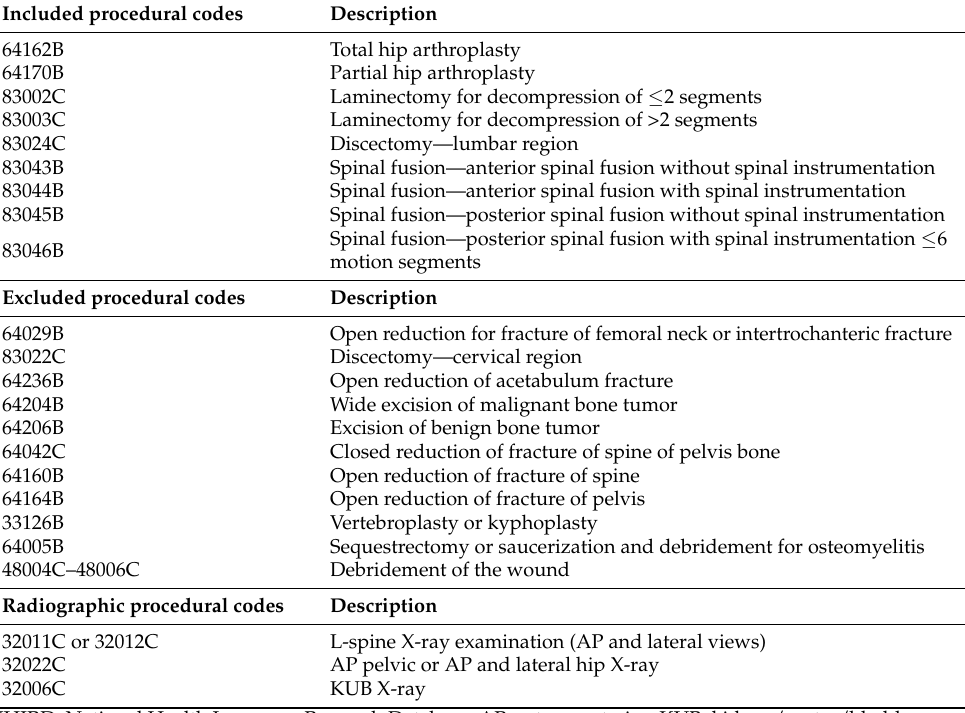
Table A1. Summary of spine, hip arthroplasty, and radiology procedure codes used to select patients from the Taiwan